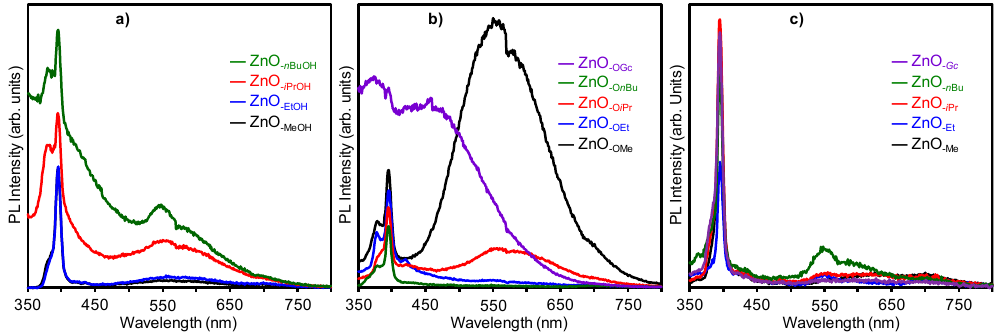
Figure 12. Photoluminescence spectra of ( a ) ZnO -ROH ; ( b ) ZnO -OR ; and ( c ) ZnO -R (R = Me, Et, i Pr, n Bu and Gc) NPs derived from different synthetic approaches.